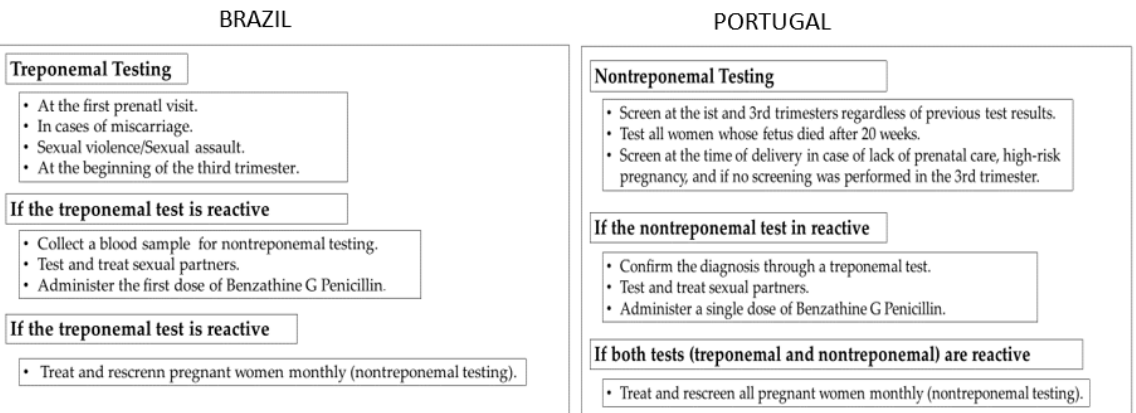
Figure 2. Flowchart of procedures for diagnosis and treatment of MS in Brazil and Portugal. The figure demonstrates the testing and treatment guidelines adopted in each country. Source: authors’ elaboration (Brazil: DCCI/SVS/MS; Portugal: DGS).